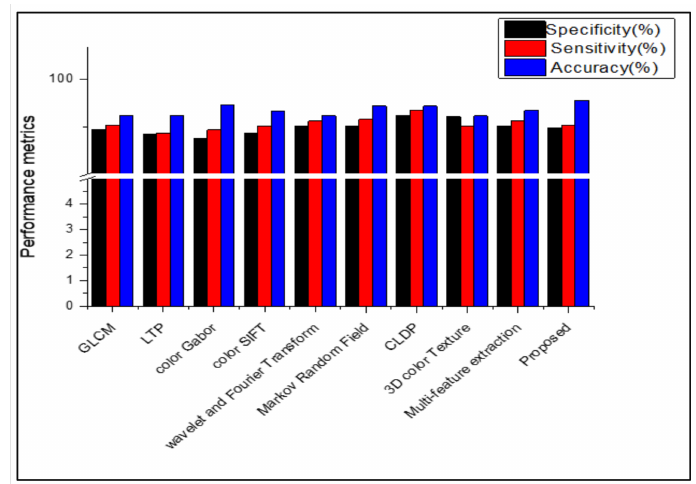
Figure 10. Comparison of performance using various features in ISIC 2016.